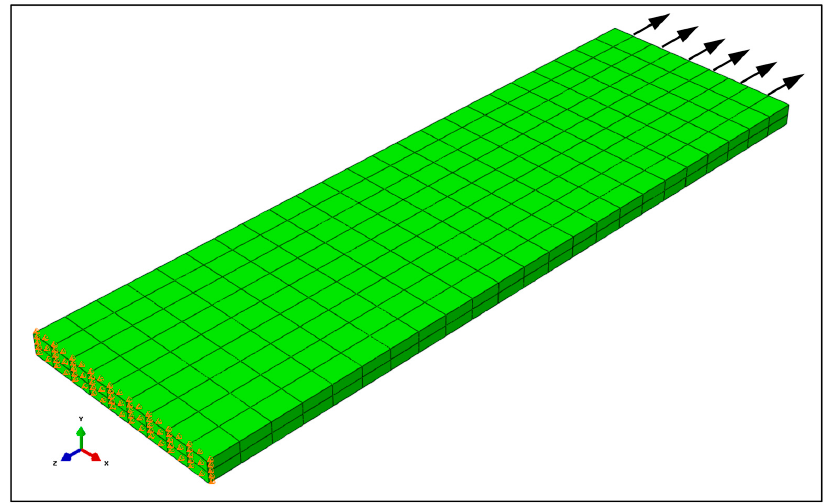
Table 3. Linear micromechanics analysis results.